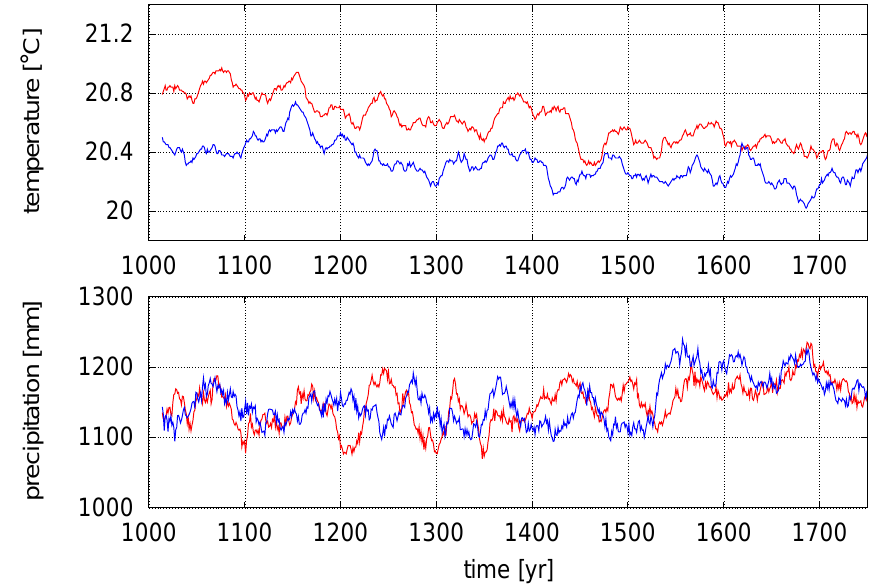
Fig. 3. 30-year running mean of simulated near-surface air temperature (top) and precipitation (bottom) for the period 1000–1750AD. Shown are the ensemble simulations Erik1 (red) and Erik2 (blue) conducted with the atmosphere-ocean model